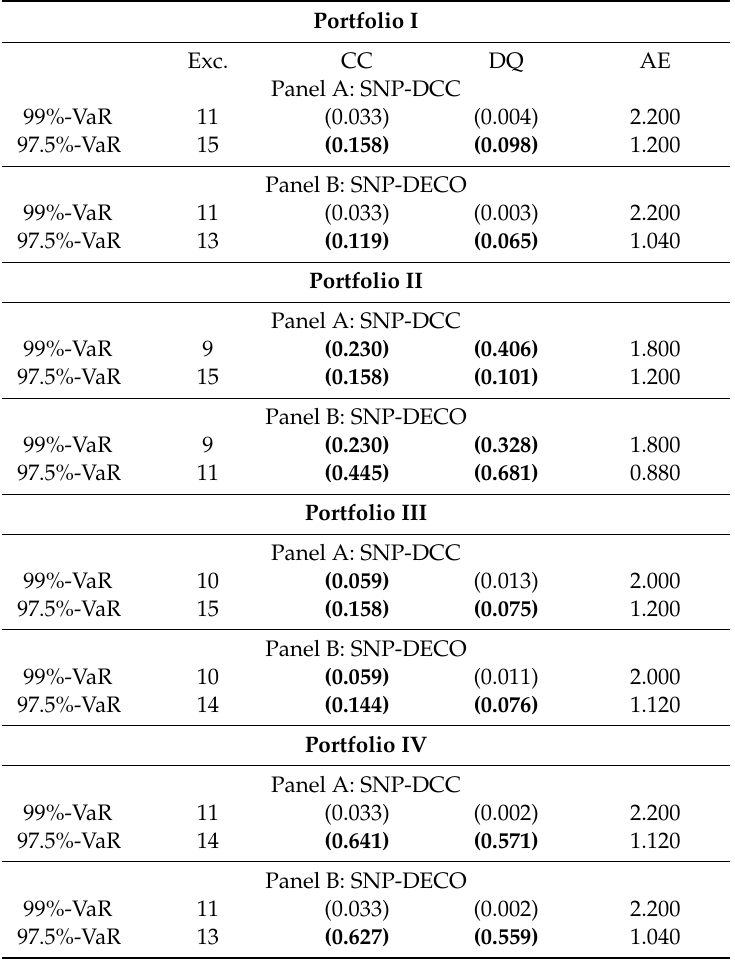
Table 3. VaR Backtesting for semi-nonparametric (SNP) DCC and DECO